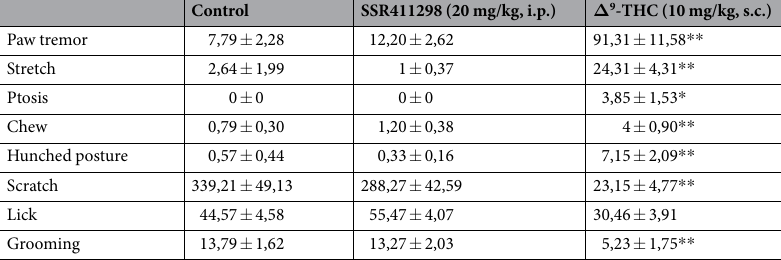
Control SSR411298 (20 mg/kg, i.p.)